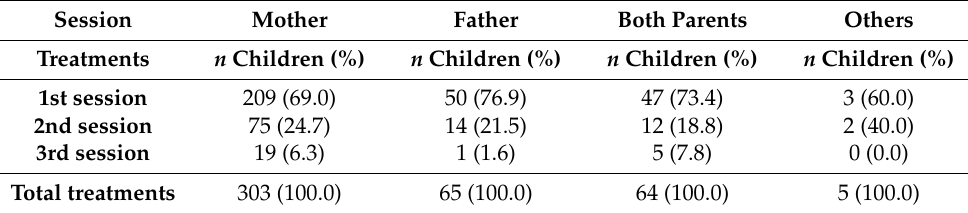
Table 2. Type of accompanying persons of the 1st, 2nd or 3rd treatment session with number of children ( n ) and percentage ( % ).